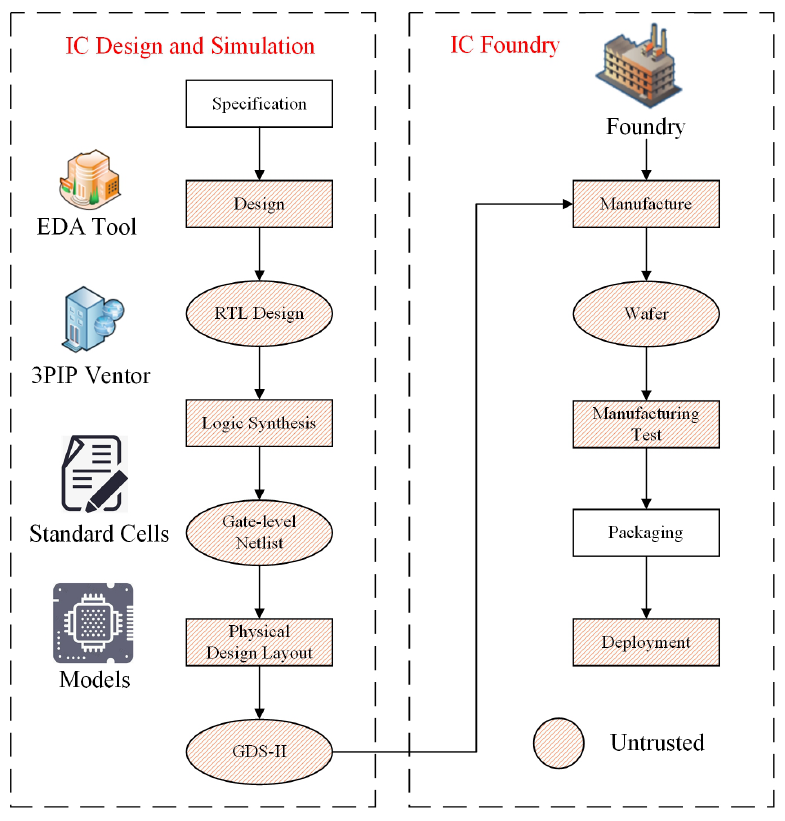
Figure 1. FPGA/ASIC design flow and potential insertion of